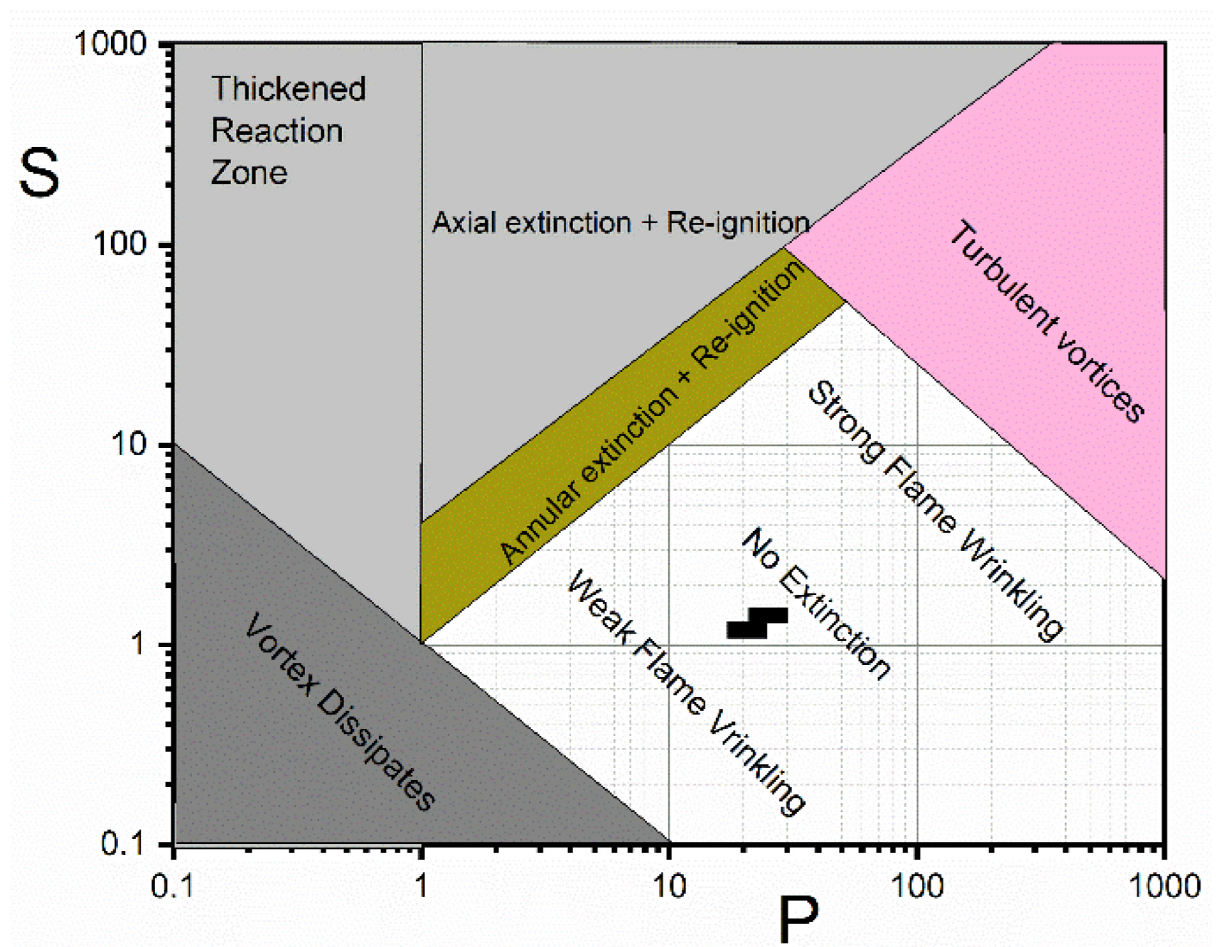
Figure 11. Diagram for non-premixed flame/vortex interactions [40]. Black marks: higher-methane,